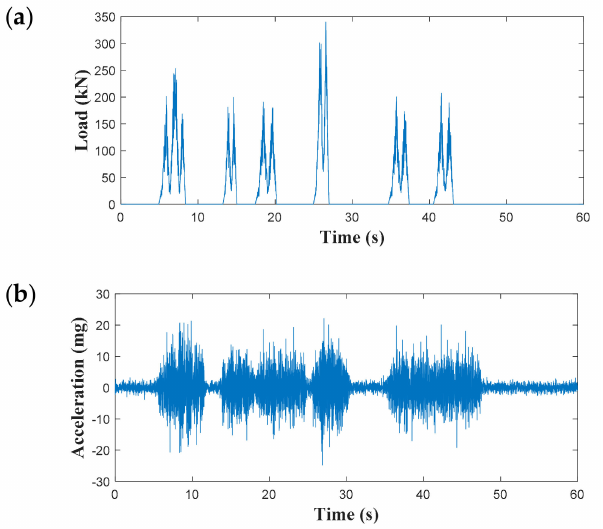
Figure 6. Examples of traffic loading excitation—( a ) load on node 1 and ( b ) acceleration response of node